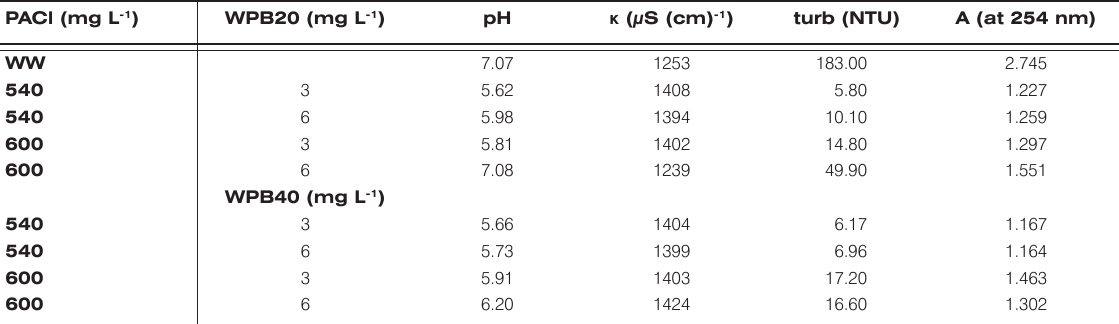
Table 4. Measurements when using WPB20 and WPB40 in combination with